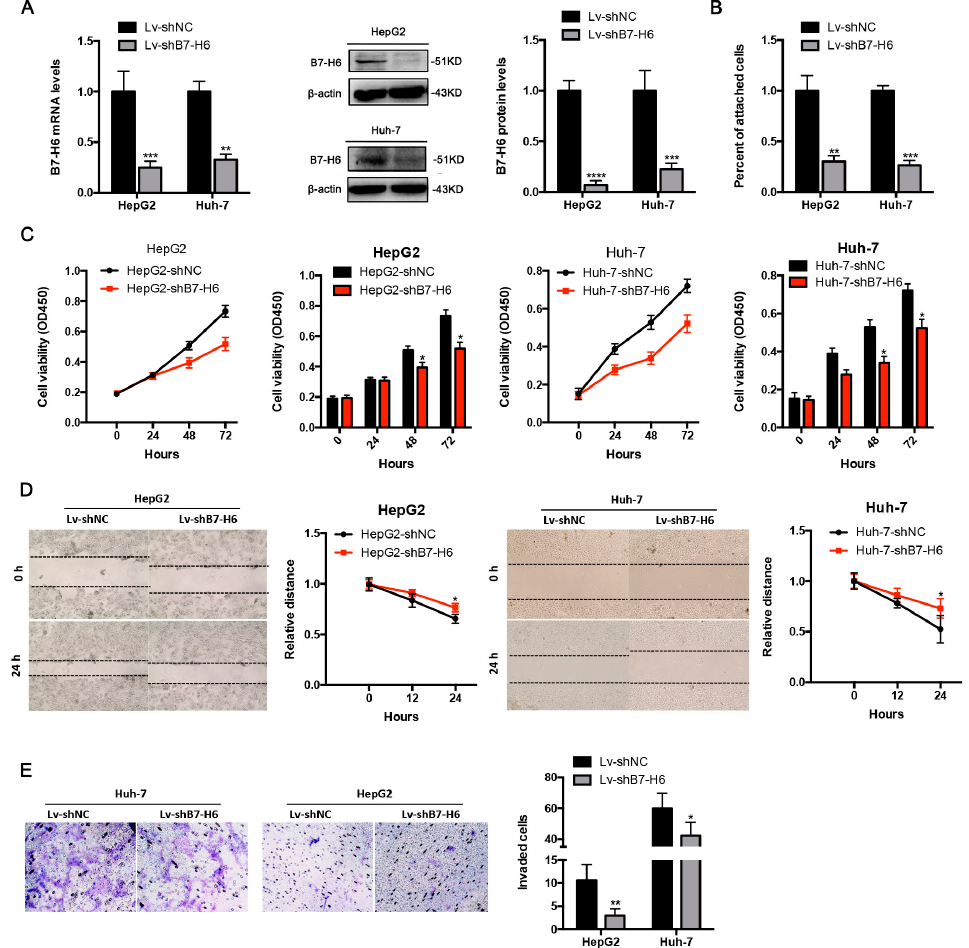
Figure 6. Knockdown of B7-H6 inhibits adhesion, proliferation, migration and invasion of HCC cells. ( A ) The knockdown rates of B7-H6 in HepG2 and Huh-7 by RT-qPCR and Western blot are shown. ( B ) Adhesion assays showed that adhesion capacity was reduced in HCC cells after transfected